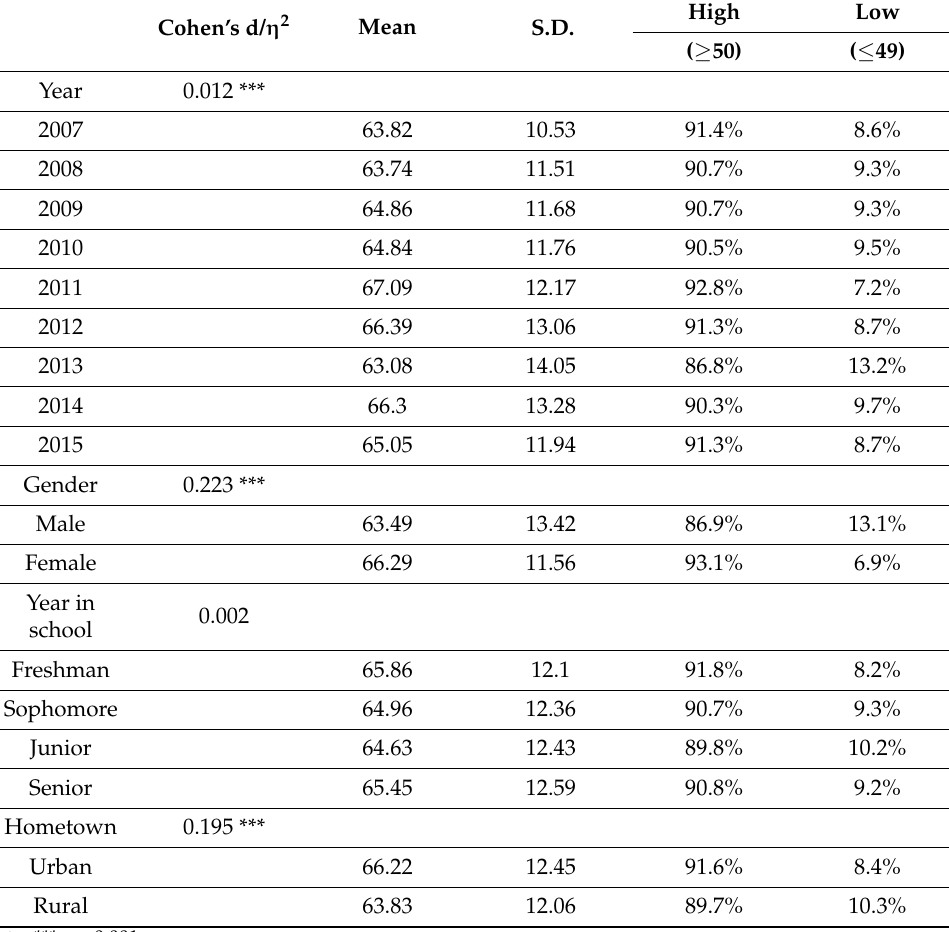
Table 5. Perceived social support among college students from 2007 to